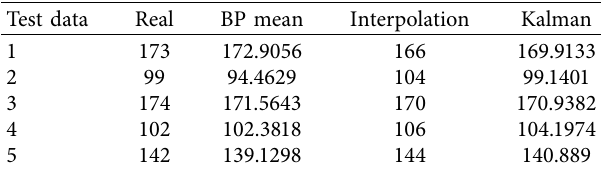
C < 42 A. (b) The comparison of errors when Table 4: RMSE and MAPE comparisons of three predicting C < 42